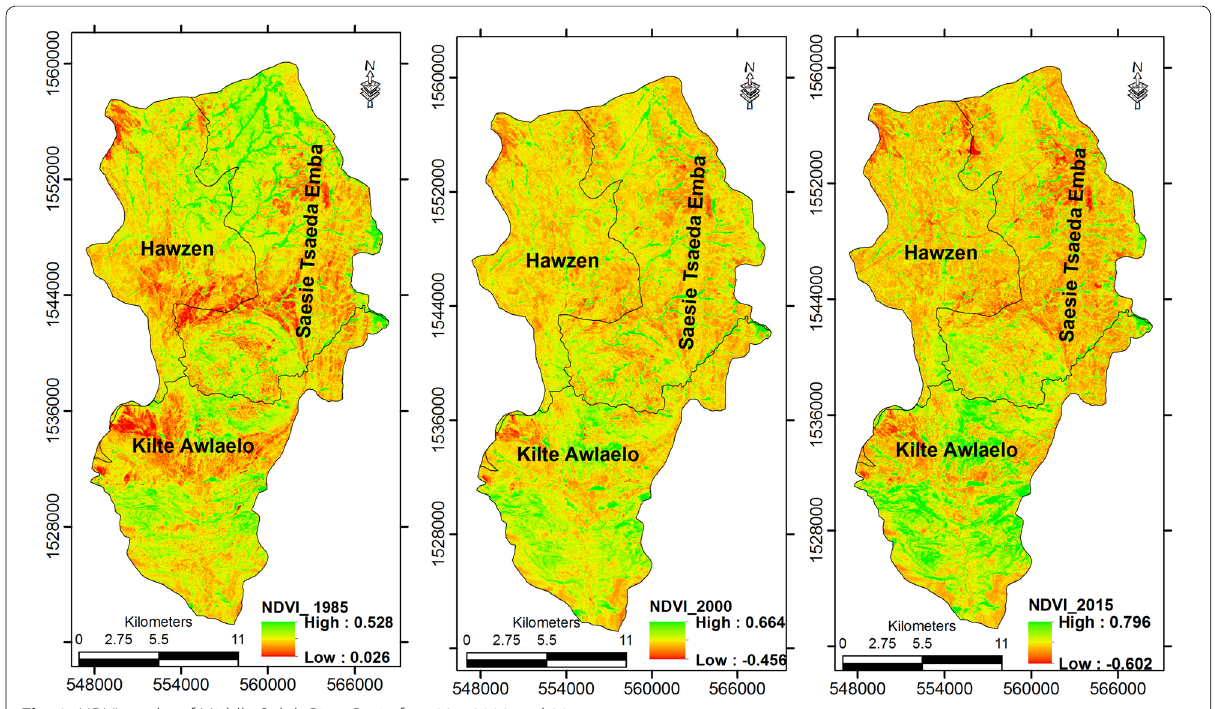
Fig. 2 NDVI results of Middle Suluh River Basin for 1985, 2000 and